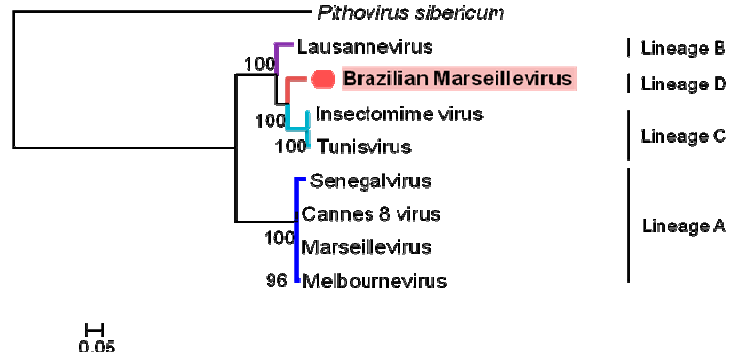
Figure 6. Phylogenetic reconstruction based on a concatenated alignment of the five core genes, DNA polymerase B, major capsid protein, VV-A18 helicase, D6/D11 helicase and D5 helicase. The amino acid sequences were aligned using Muscle and the tree was built using FastTree. Pithovirus sibericum was used as an outgroup. Branches delineating the different lineages of the family Marseilleviridae are colored (dark blue for lineage A, purple for lineage B, blue for lineage C and red for lineage D). Viruses 2016 , 8 , x 12 of 16